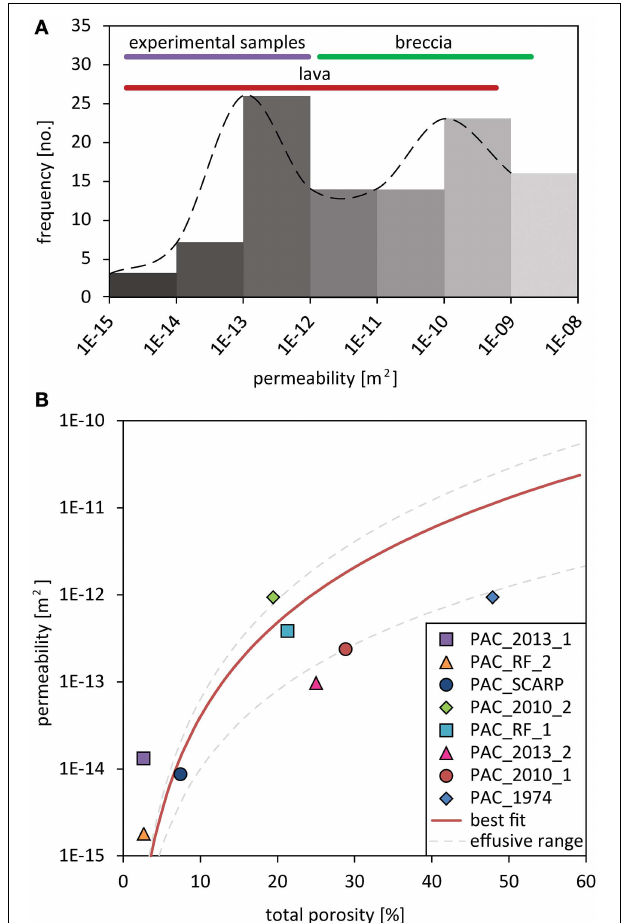
FIGURE 4 | (A) Permeability frequency of in-situ rocks at Pacaya from 97 measurements made using a portable permeameter during fieldwork in October 2013. The data shows that the permeability of lavas spans a wider range than that of breccias (defined, here as unconsolidated volcanic deposits). The samples collected for the experimental study had low relative permeability so as to constrain the strength of intact material associated with failure, such as in edifice collapse. (B) Permeability vs. porosity for each sample selected for this study. The best fit regression of the dataset falls within the porosity-permeability relationship for effusive lavas described by Mueller et al.